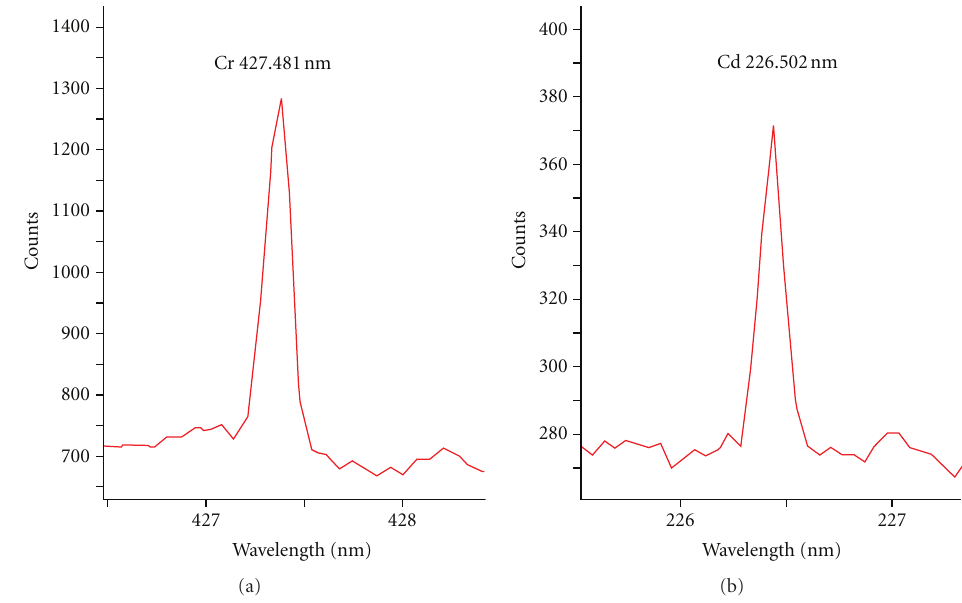
Figure 2: LIBS spectra of chromium and cadmium standards showing emission lines at 427.481 nm and 226.502 nm,